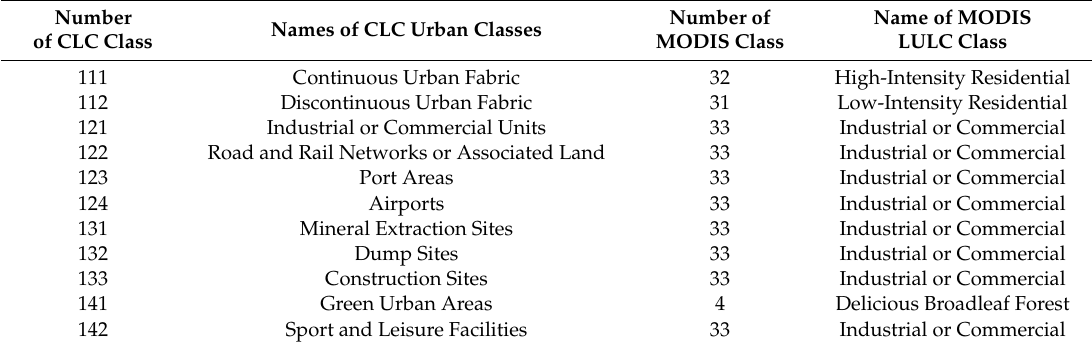
Table 4. Scheme of reclassification for the urban area LULC categories, from CLC to MODIS classes.